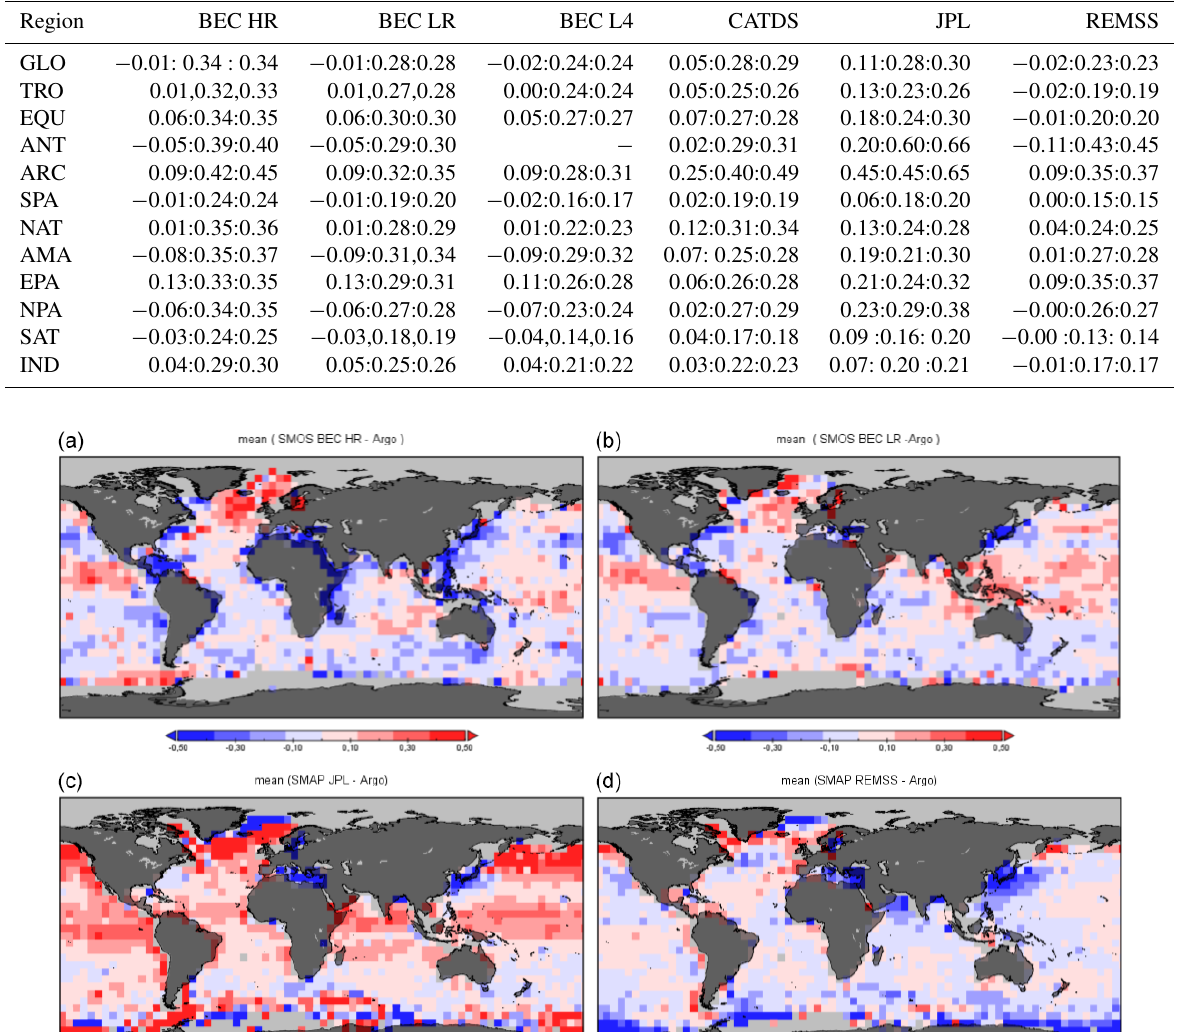
Table 6. Regional statistics of the differences between the satellite and Argo SSS for the year 2016. For each product and ocean region the mean, standard deviation, and root mean square of the difference are provided separated by a colon.